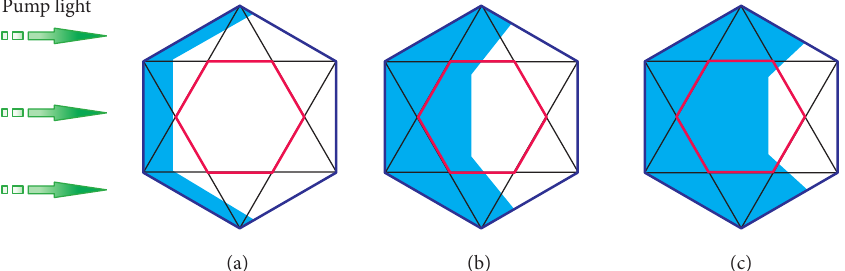
Figure 4: The change of multiphoton absorption region in the microrod with pump power increase: (a) low power; (b) higher power; (c) high power.